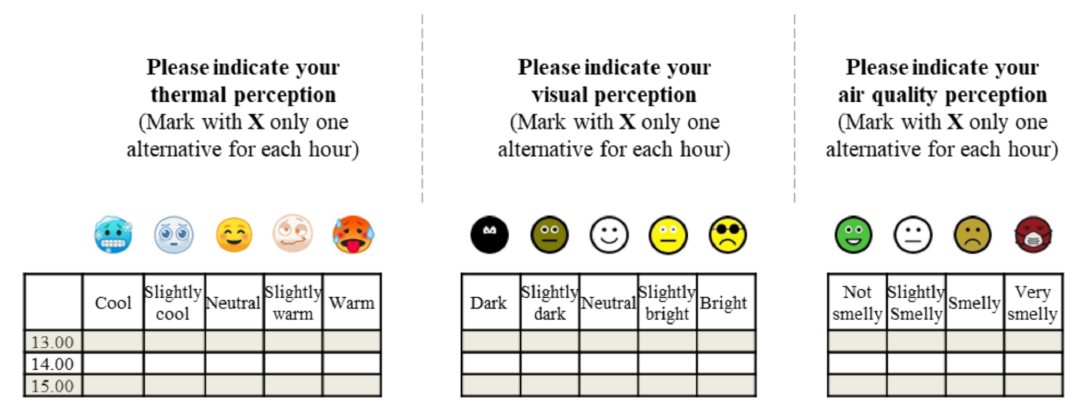
Figure 2. Questionnaire structure about thermal, visual and IAQ perception (translated from Albanian).